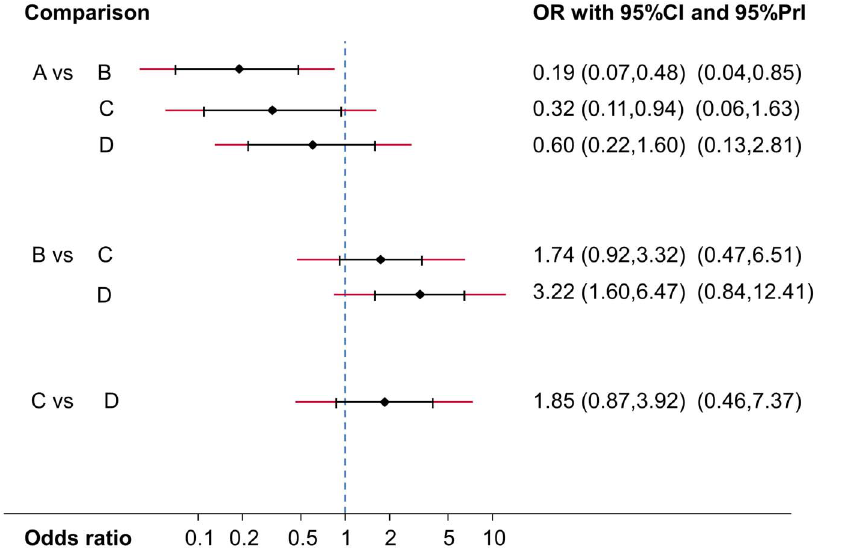
Figure 4. Network estimates of mean ORs, their 95% confidence intervals and 95% predictive intervals (red extensions). The names of the treatments are given in Figure 1.